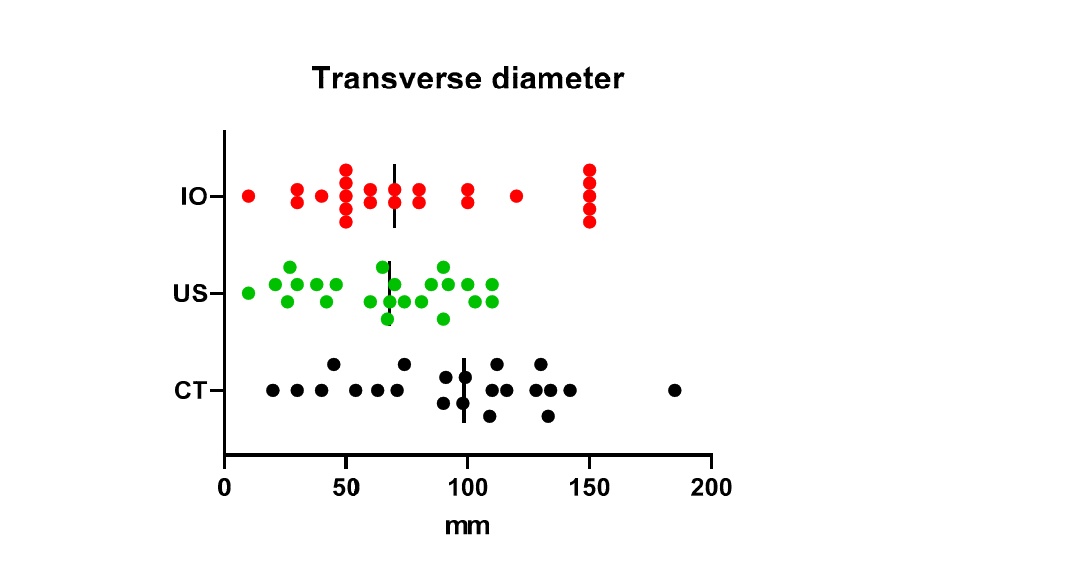
Figure 3. Transverse diameter comparison using US and CT (US = ultrasound, CT = computed tomography, IO = intraoperatively).